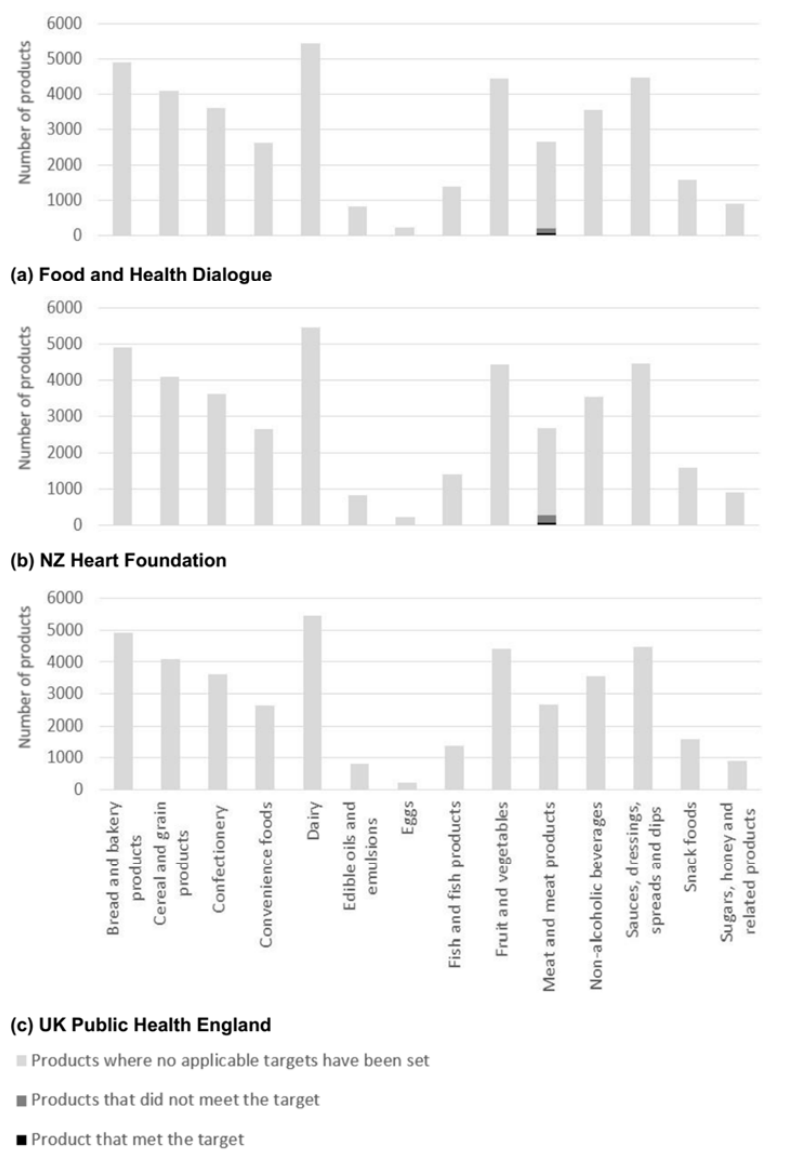
Figure 3. Number of Australian packaged food products without, with and meeting saturated fat reformulation target set by either ( a ) Food and Health Dialogue [28]; ( b ) New Zealand Heart Foundation [31]; and/or ( c ) United Kingdom (UK) Public Health England *. * Where averages and maximum limits we both specified, maximum limits were used for analysis.